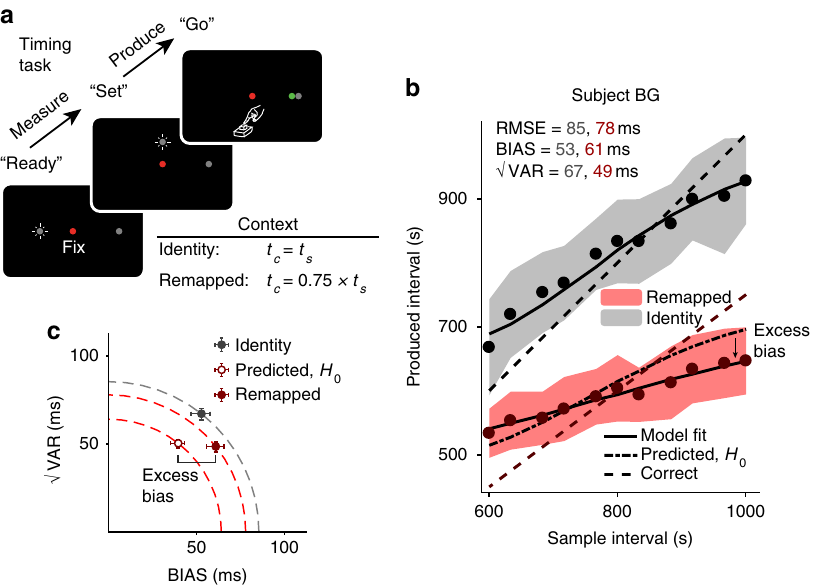
Fig. 4 Time measurement and production task, gain = 1 and 0.75. a Trial structure. Trial structure and feedback schedule were identical to that described in Fig. 2a, except that in the remapped context, the gain was 0.75. b Performance of an example subject in the identity (gray) and remapped (red) contexts. Results are shown in the same format as Fig. 2 except that the remapped data correspond to the gain of 0.75. Similar to gain = 1.5 (Fig. 2b), the subject ’ s behavior shows excess bias beyond what was predicted assuming no additional MTN. The same identity context data was used as a comparison for both gain = 0.75 and gain = 1.5. Shaded regions show mean ± one standard deviation. c √ VAR vs. BIAS plot for the gain of 1 and 0.75 shown in the same format as Fig. 2c. RMSE in the and BIAS in the remapped context were both larger than predicted assuming no additional MTN. Error bars represent 95% con fi dence intervals estimated using a bootstrap procedure ( n =